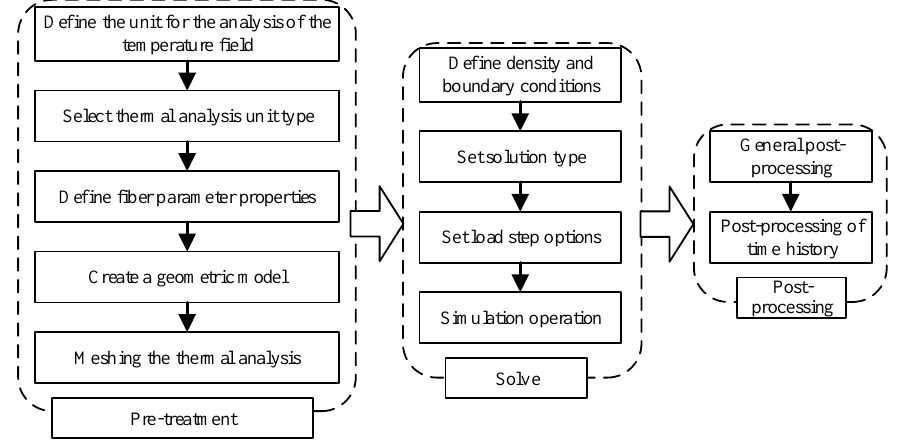
Figure 4. Temperature field analysis steps. Table 1. Polyether ether ketone (AS4 / PEEK) material properties.